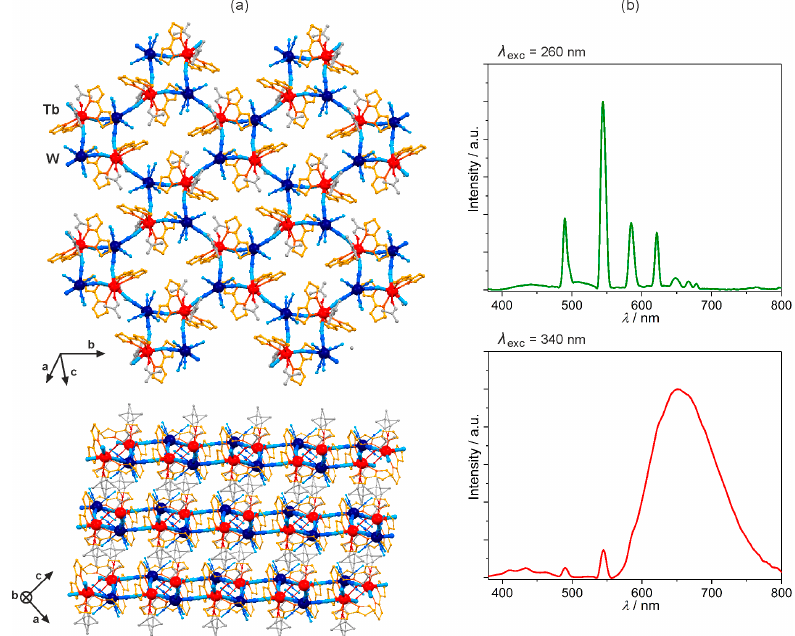
Figure 8. Crystal structure and optical properties of two-dimensional [Tb III (box) 2 (dmf) 2 ] [W V (CN) 8 ]·H 2 O (box = 2,2’-bis(2-oxazoline)) coordination polymers: ( a ) the views of the single cyanido-bridged layer, and the arrangement of layers, ( b ) the excitation-dependent emission spectra collected at T = 77 K. Colours for the structural diagram: Tb, red; W, dark blue; CN − , blue; box, orange; dmf, grey [109]. Table 4. Photoluminescent octacyanidometallate-based compounds containing lanthanide ions. Compound